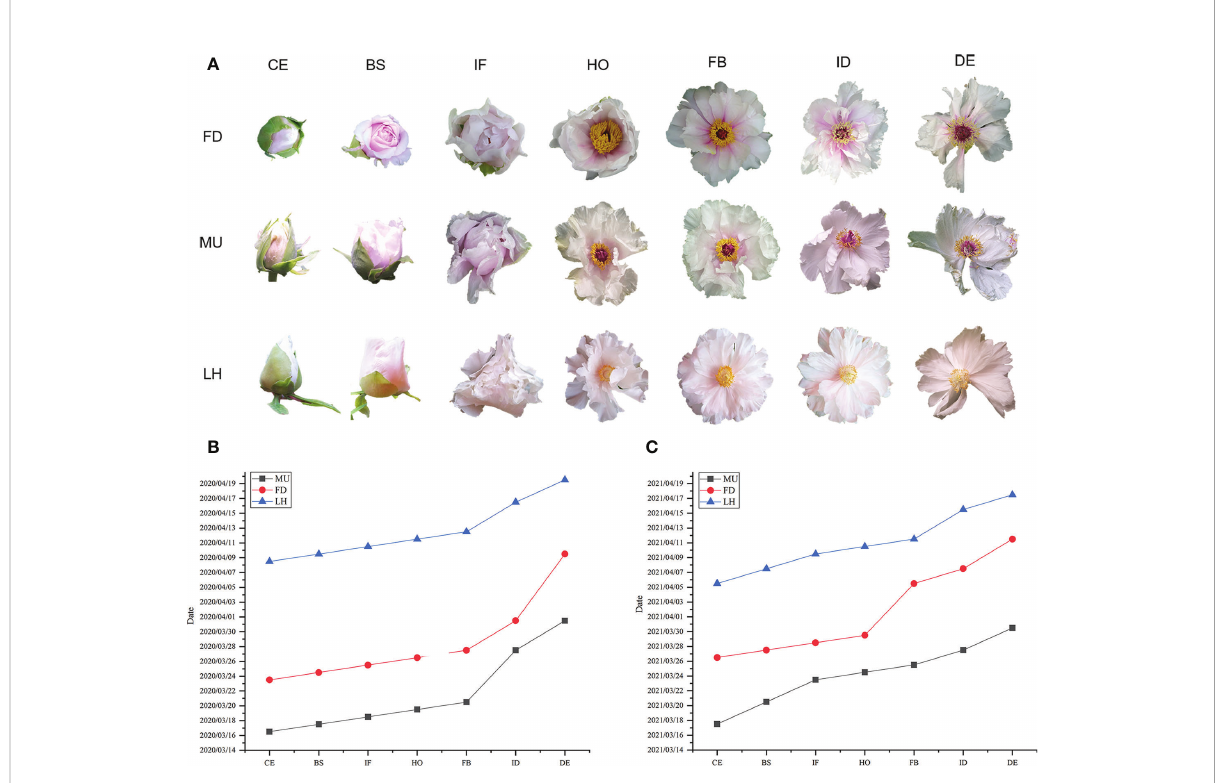
FIGURE 1 Phenotype and fl owering time investigation of FD, MU, and LH. (A) Flower phenotype at different developmental stages of FD, MU, and LH. (B) The date when 80% fl owers reached different development stages in FD, MU, and LH investigated in 2020. (C) The date when 80% fl owers reached different development stages in FD, MU, and LH investigated in